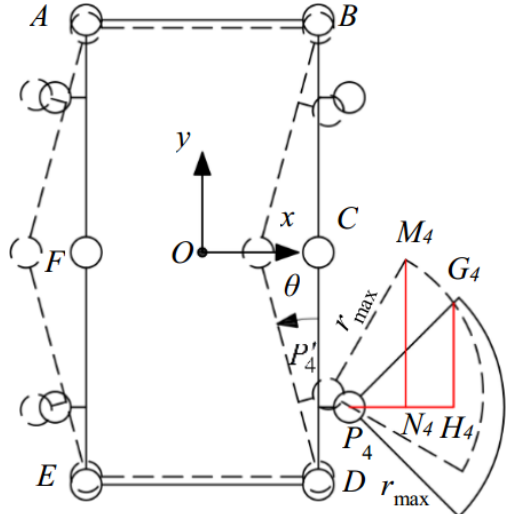
Figure 5. Reachable areas on the ground of leg 4. The quadrant in solid line is the reachable area before trunk twisting, the quadrant in black dash line is that after trunk twisting.